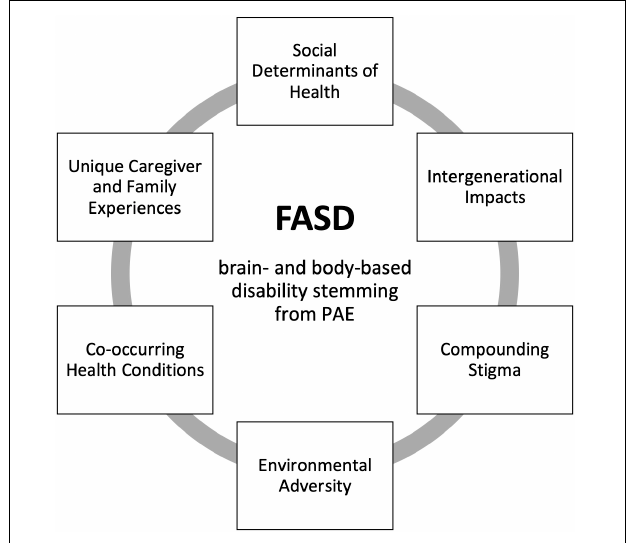
FIGURE 1 | Factors contributing to the unique complexity of FASD. FASD, fetal alcohol spectrum disorder; PAE, prenatal alcohol